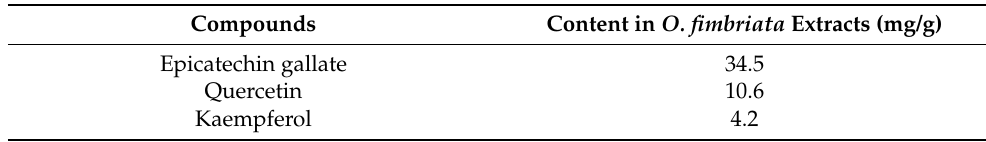
Table 3. Quantification of epicatechin gallate, quercetin, and kaempferol in Orostachys fimbriata ex- tracts.